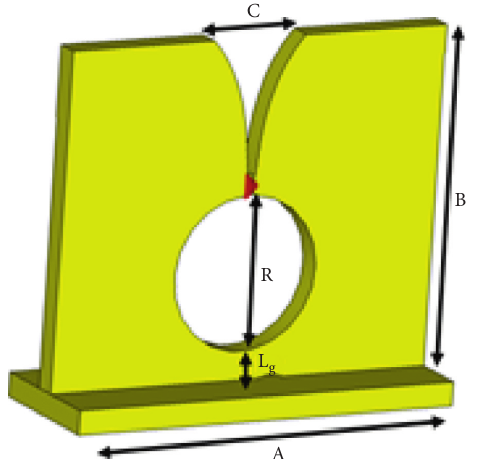
Figure 2: Single element parameters